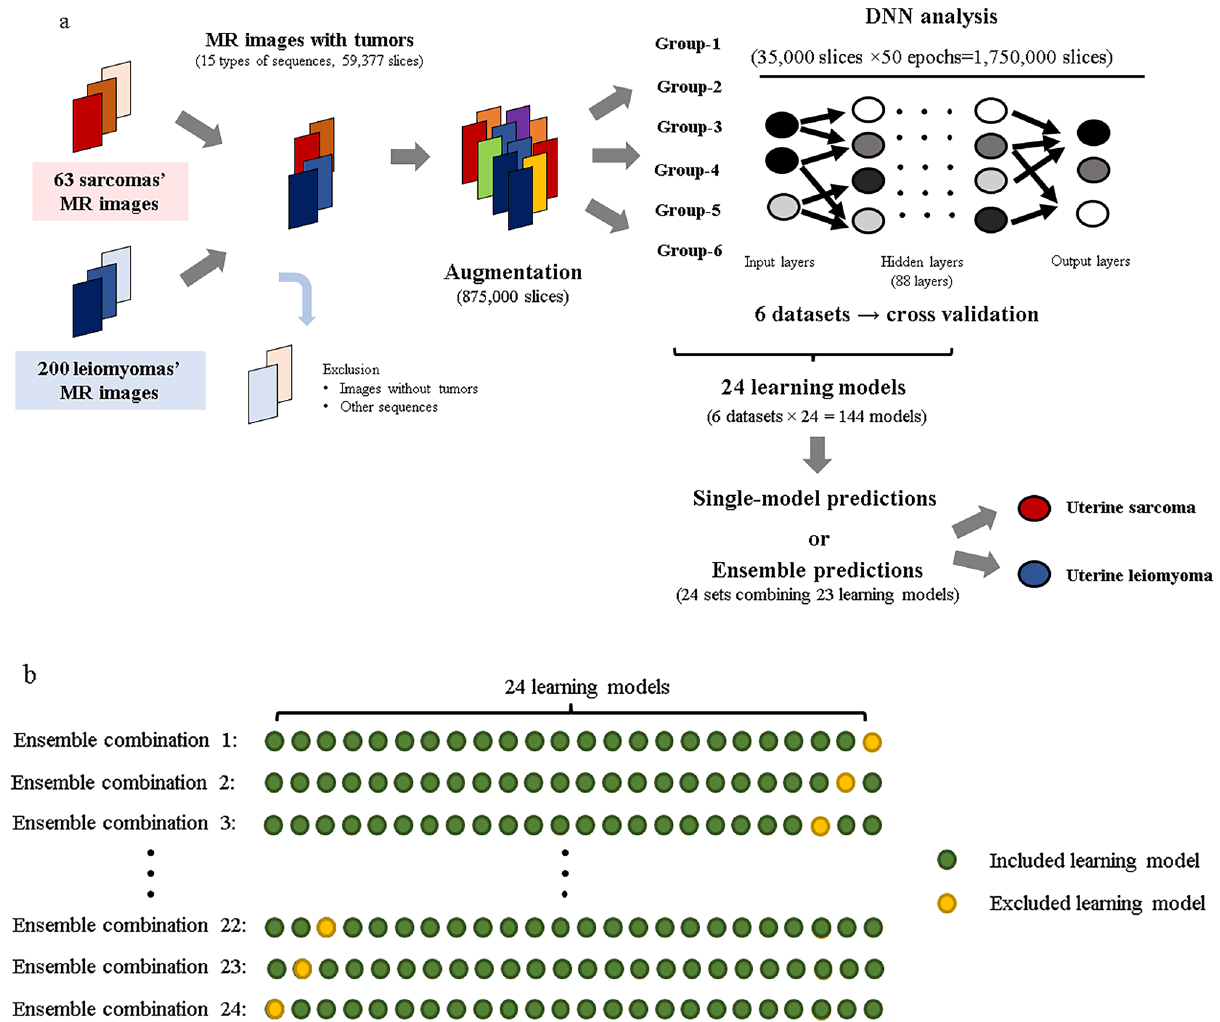
Figure 4. Study flow of DNN learning and evaluation. ( a ) MRI slices of uterine leiomyomas and sarcomas are augmented to 875,000 slices. In one epoch, 35,000 slices are selected randomly out of 875,000 slices and the model repeats learning 50 times. The ratio of the learning set to the evaluation set is 5:1, which is cross validated. The DNN models are evaluated as “a uterine sarcoma” or “a uterine leiomyoma” using either a single- model prediction or ensemble prediction. The augmentation method we adopted was a very general approach that included flips, rotations, zooms, and changes to the brightness. ( b ) For evaluation, 24 sets of ensemble predictions are performed along with single-model predictions. The predictions of the ensemble model combine the results of 23